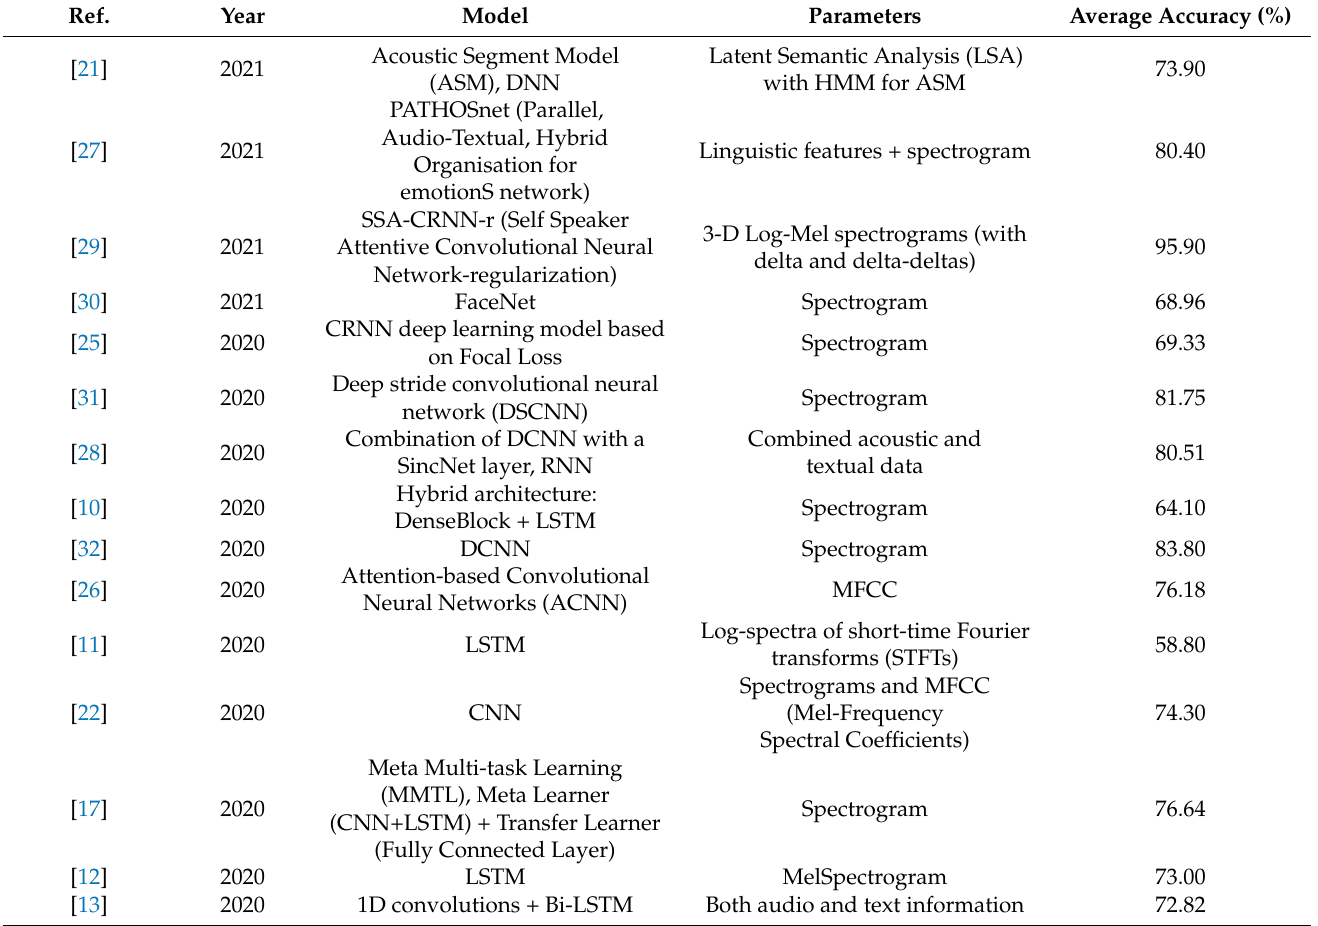
Table 14. Summary of research results on speech emotion recognition with IEMOCAP and for four